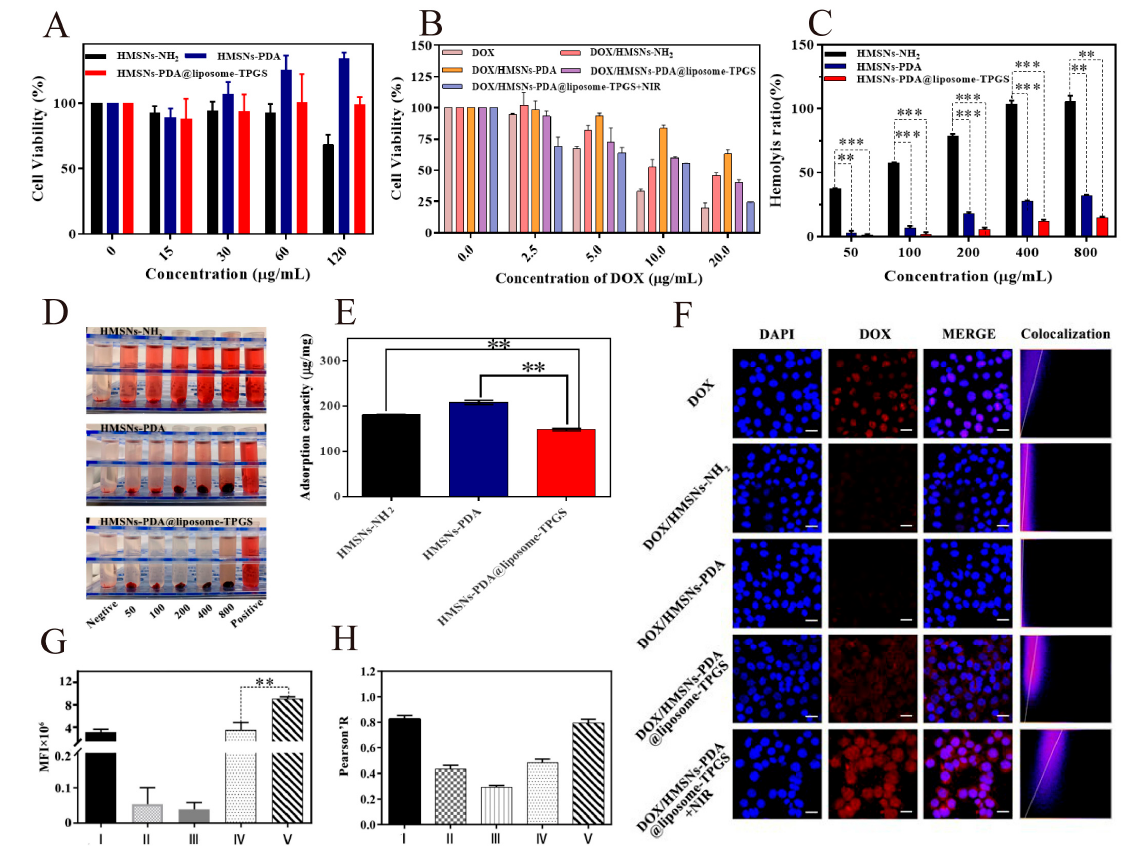
Figure 4. The cell viability after incubation with blank carriers ( A ) and DOX-loaded nanoparticles ( B ) for 24 h. ( C ) The hemolysis ratio of HMSNs-NH 2 , HMSNs-PDA, and HMSNs-PDA@liposome-